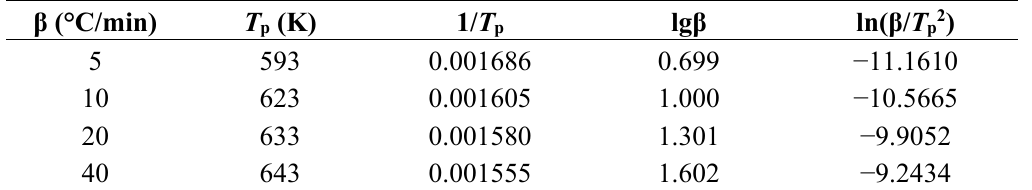
Table 5. Thermal reaction kinetic parameters of Sample 5 paraffin-based fuel in O 2 by DSC. β (°C/min) T (K) 1/ T p p